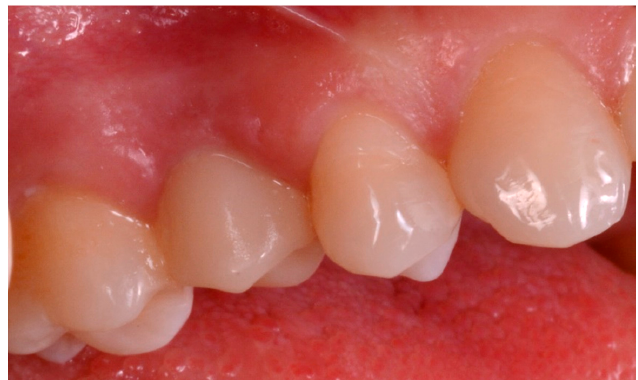
Figure 14. Delivery of the final monolithic translucent zirconia restoration. In all cases, no physical models of the jaws were